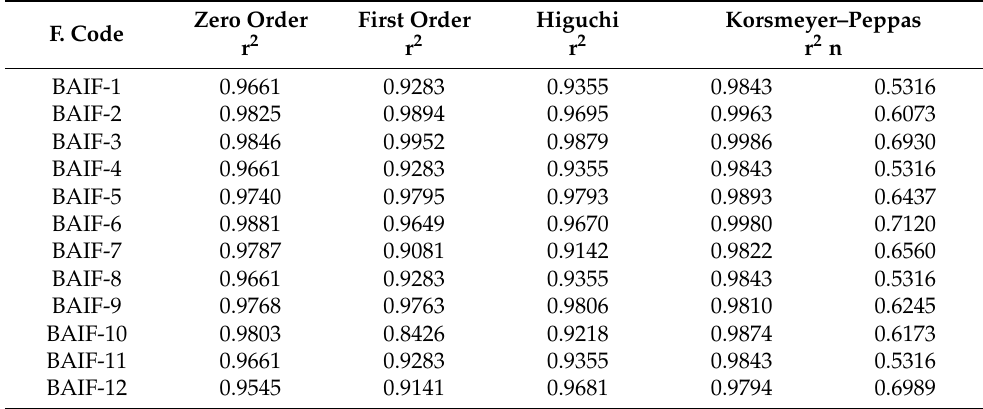
Table 3. Kinetic modeling release of THP from β -CD- g -P(Aa/Ia) hydrogels. F.